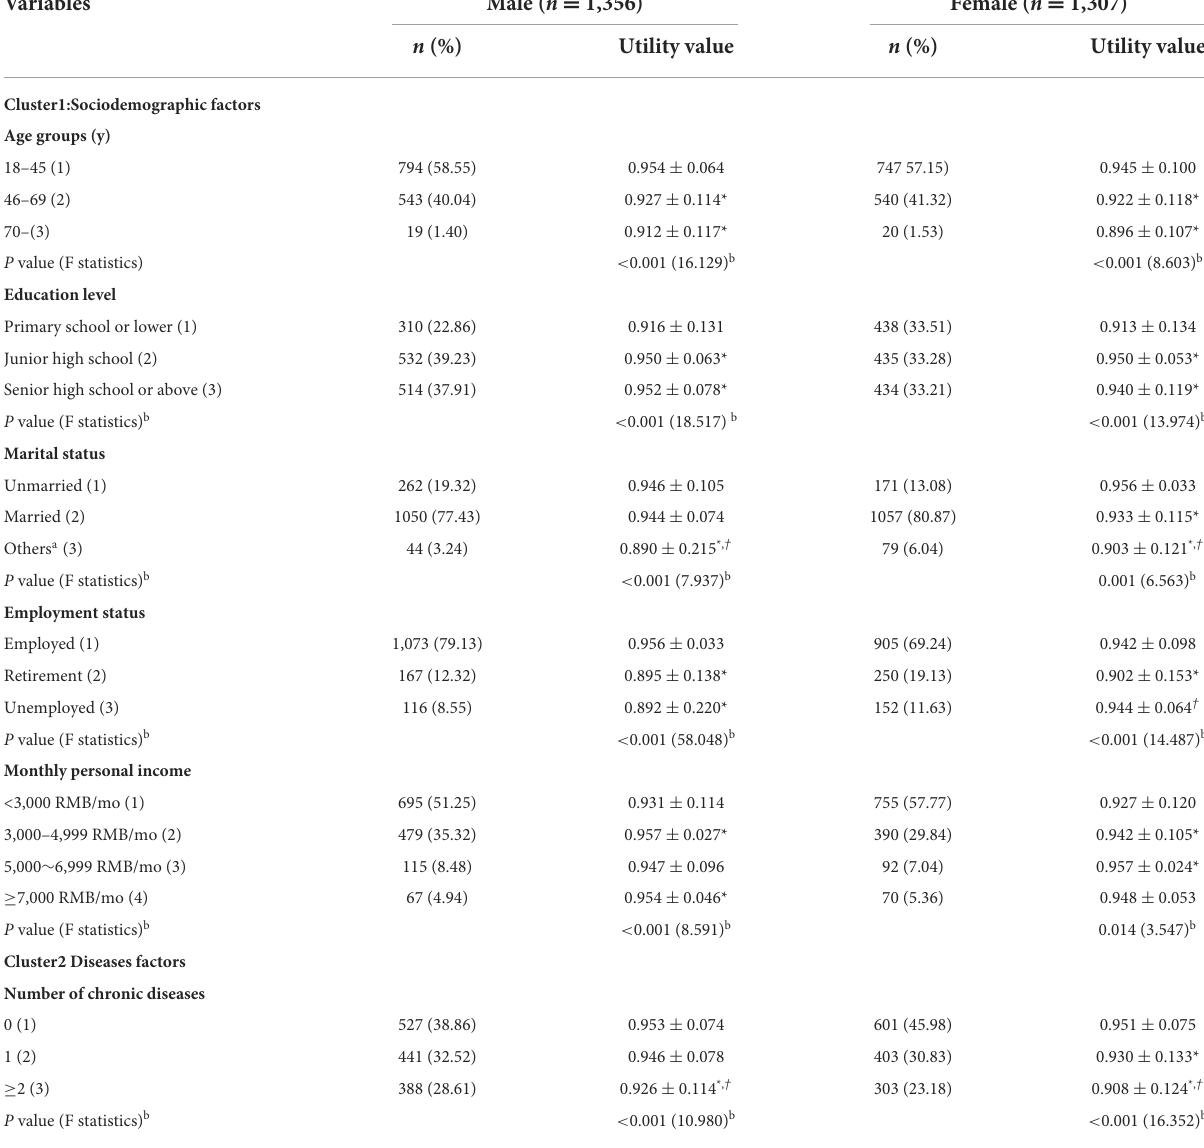
TABLE 1 Comparison of HRQoL of community residents with different demographic characteristics by gender ( n = 2,663). Variables Male ( n = 1,356) Female ( n = 1,307) Utility value n (%) Utility